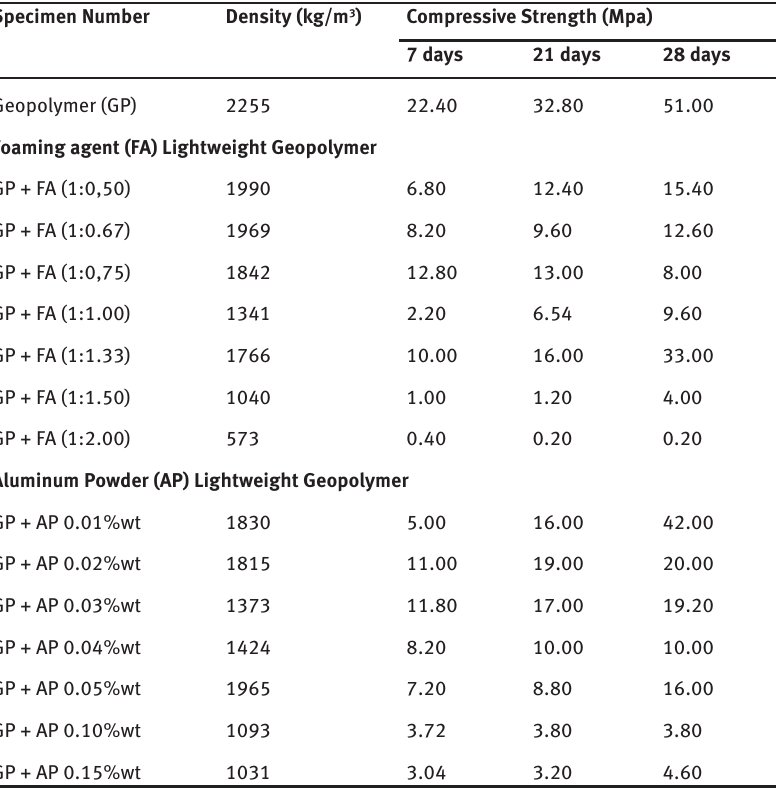
Table 4: Dry density and compressive strength of unfoamed geopolymer (GP) and both types of lightweight geopolymer. Specimen Number Density (kg/m 3 )